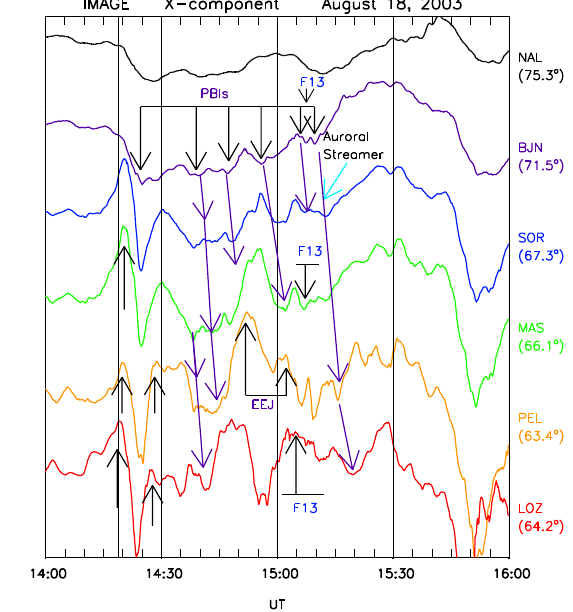
Fig. 9. X component deflections at six IMAGE stations during the interval 14:00–16:00UT. Panels from top to bottom show X compo- nent traces from stations NAL (75.2 ◦ MLAT), BJN (71.4 ◦ MLAT), SOR (67.3 ◦ MLAT), MAS (66.2 ◦ MLAT), PEL (63.5 ◦ MLAT), and LOZ (64.2 ◦ MLAT). Positive deflections in Harang region-south and negative deflections in Harang region-north are marked by ar- rows. Tilted arrowed lines are used to indicate equatorward-moving streamer events in HR-N. The time when DMSP F13 passed across the oval at dusk in the interval 15:04–15:09UT is also marked by